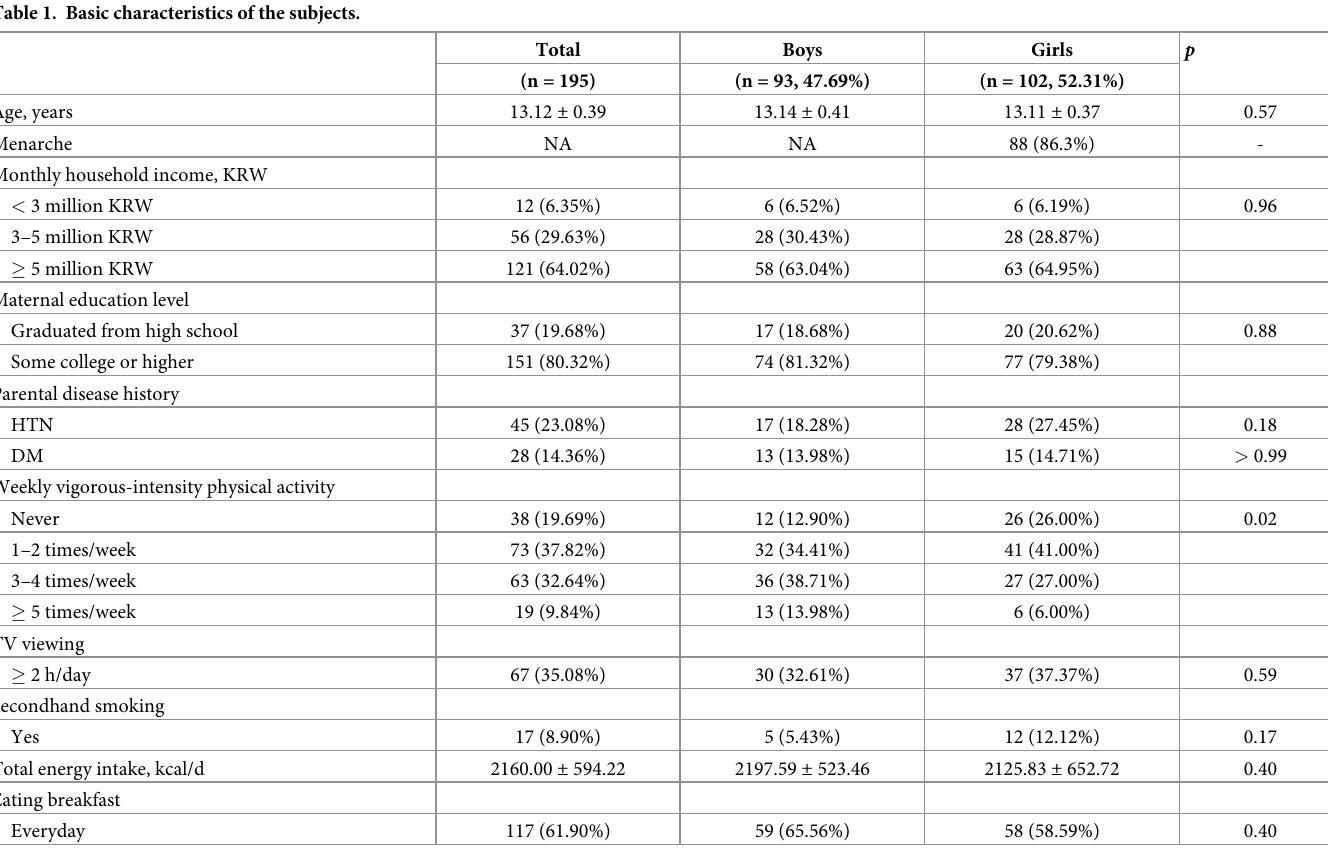
Table 1. Basic characteristics of the